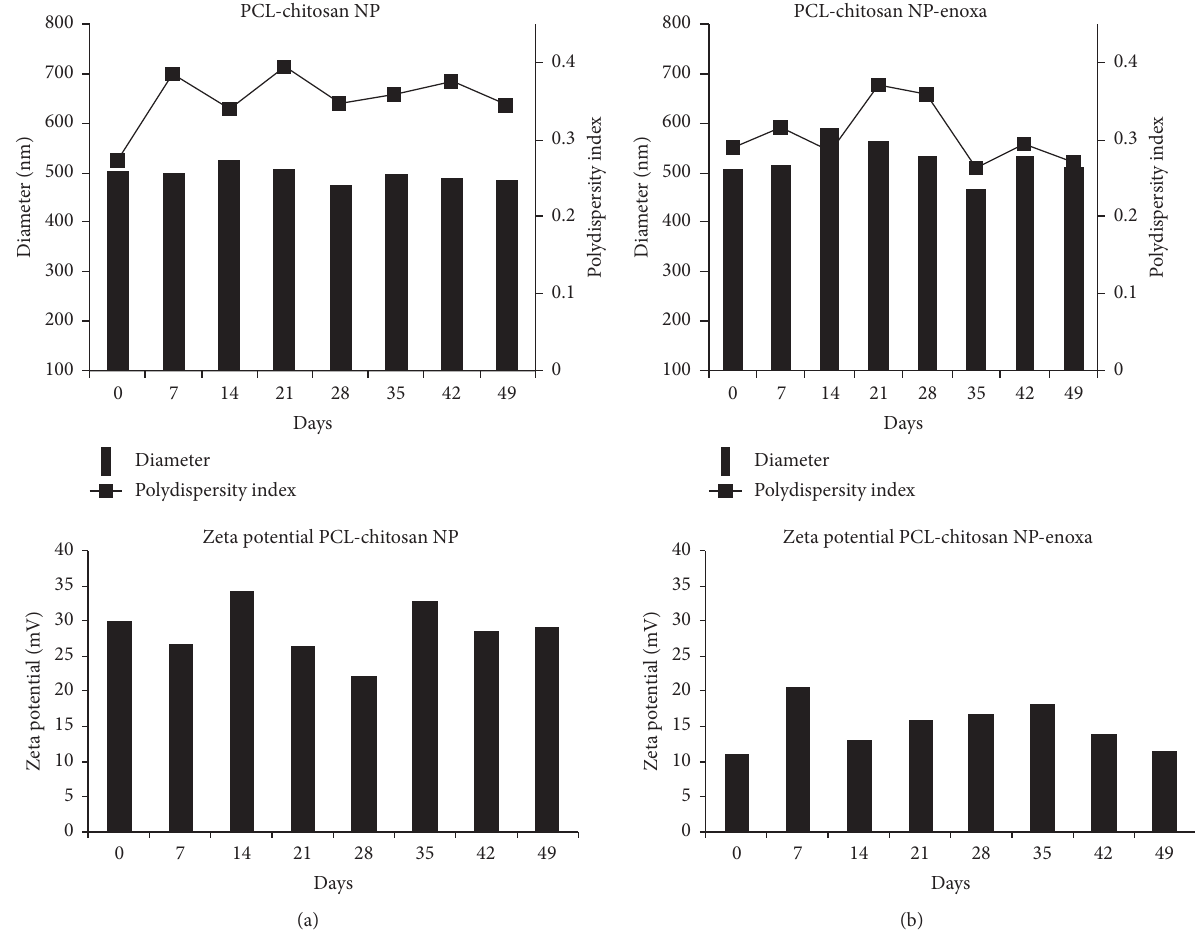
Figure 1: Diameter, polydispersity index, and zeta potential of the nanoparticles during 50 days: (a) empty nanoparticles; (b) nanoparticles containing enoxaparin.